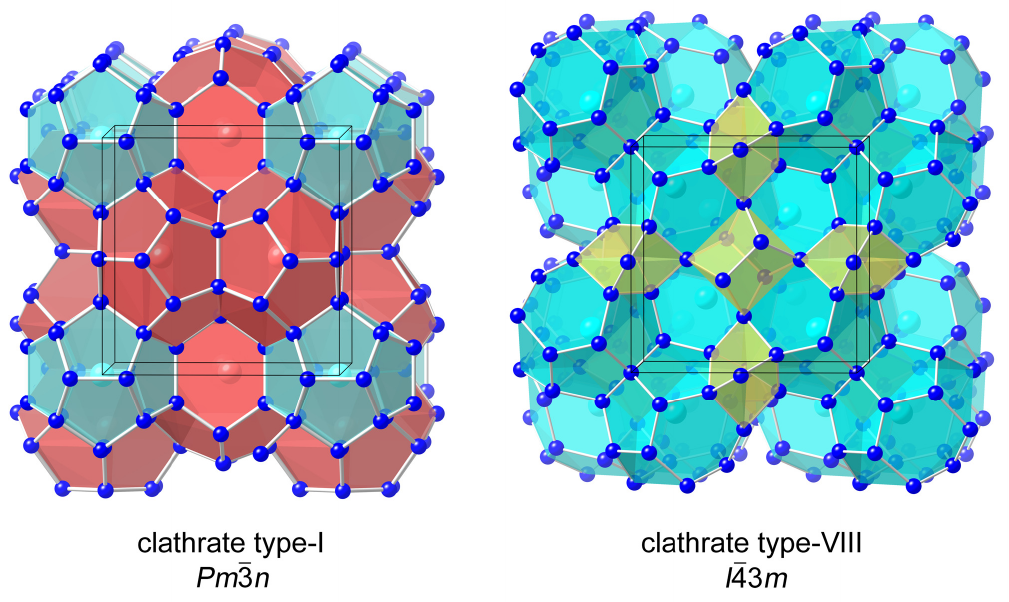
Figure 2. Crystal structures of Ba Ga Sn (type-I, left ) and Ba 8 14.5 31.5(4) VIII, right ). Ba atoms residing in the (Ga,Sn) cages (clathrate type-I) and the augmented 20 (Ga,Sn) cages (clathrate type-VIII) are drawn as light blue spheres, while the Ba atoms 20+3 residing in the (Ga,Sn) tetrakaidecahedra (clathrate type-I only) are drawn as red spheres. 24 The empty cubic voids in the clathrate type-VIII are shown in yellow.